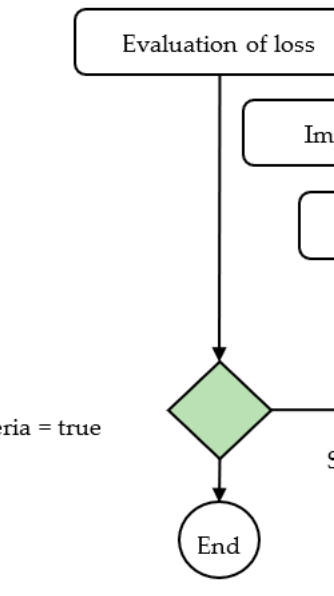
Figure 8. Layout of the Levenberg–Marquardt (LM) optimizing function.